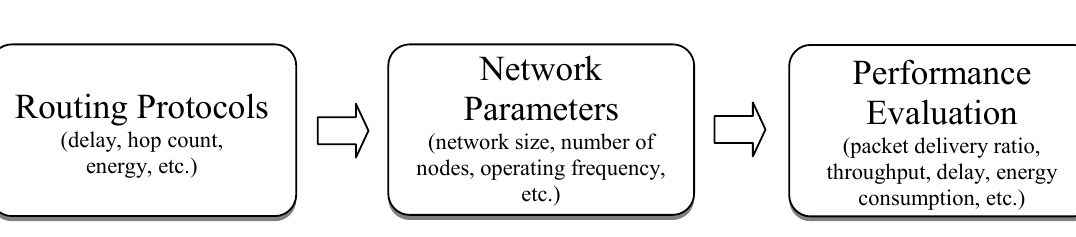
Figure 2. Performance evaluation flow of routing protocols in wireless networks.